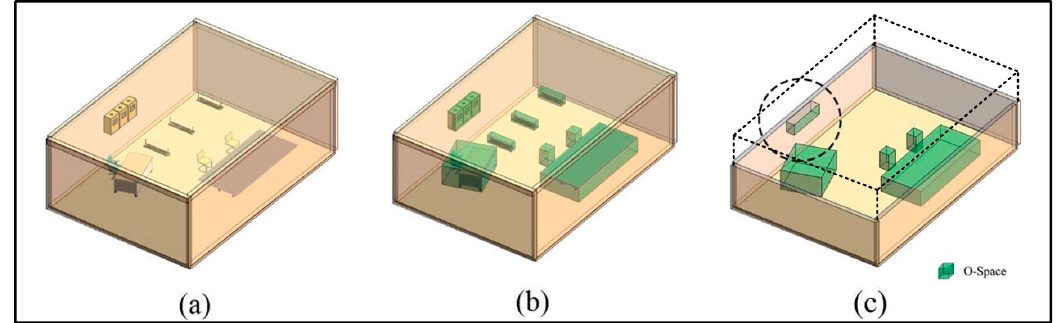
Figure 5. The layout of Room A. ( a ) Actual indoor environment. ( b ) Simplified indoor environment. ( c ) The indoor spaces after deleting S h . ( c ) The indoor spaces after deleting S (cid:2918) .